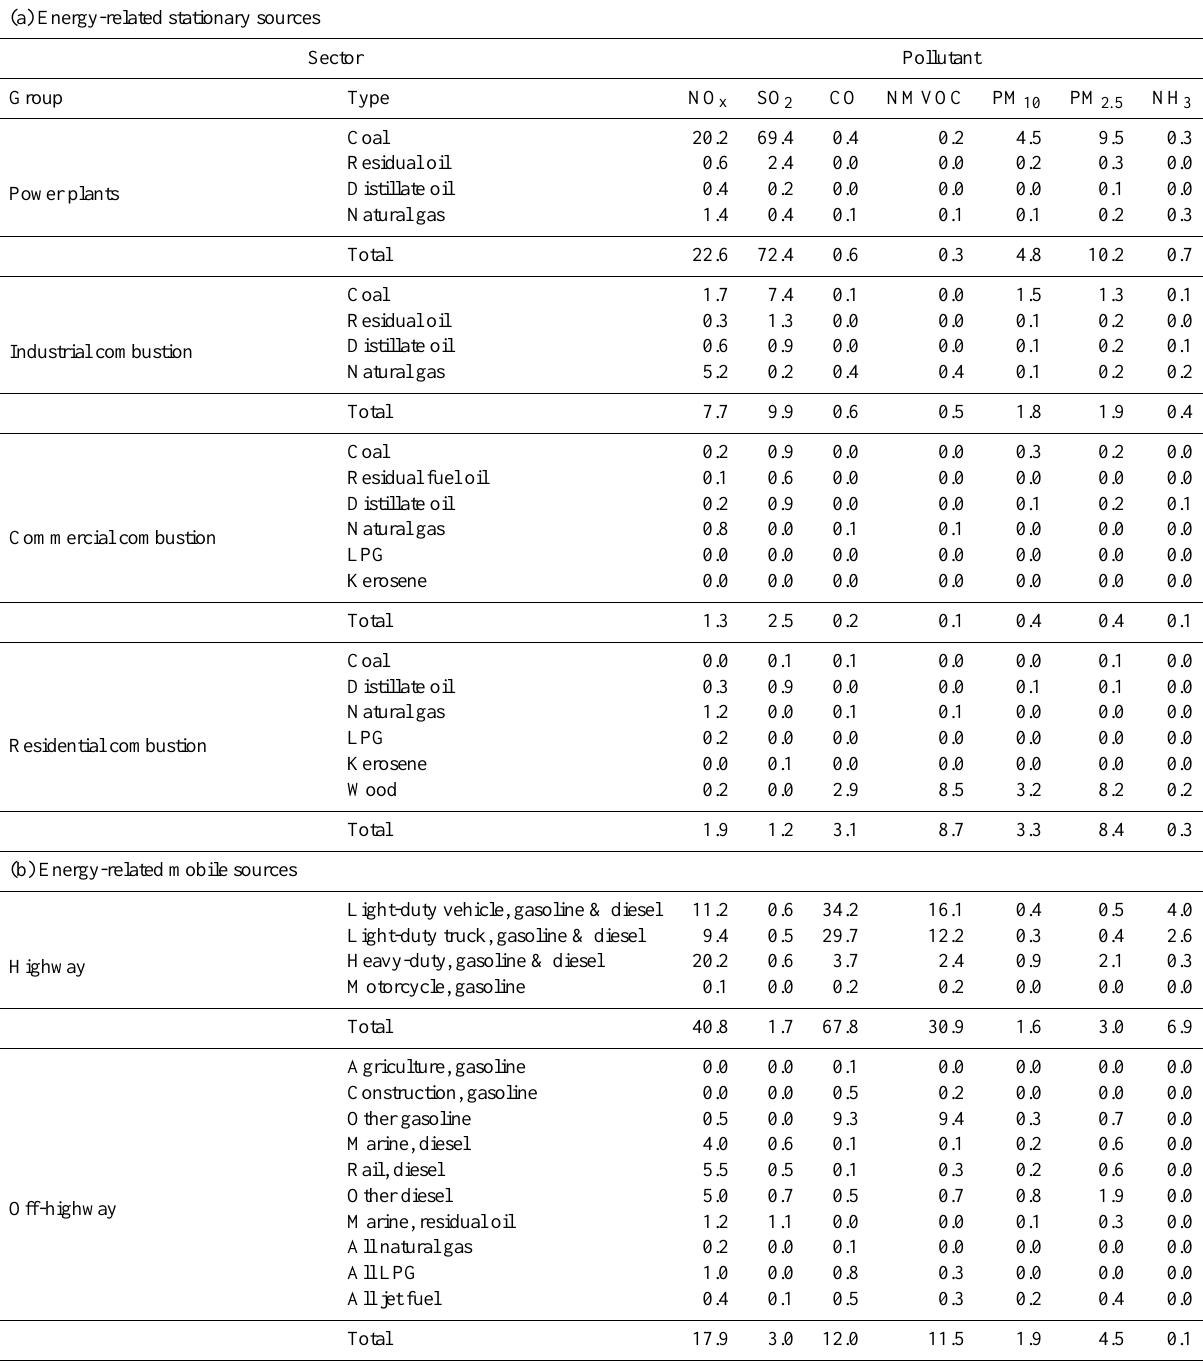
Table 1. Defined sectors and percentage of their contributions to total anthropogenic emissions (calculated from the 2002 NEI data, unit: %). (a) Energy-related stationary sources